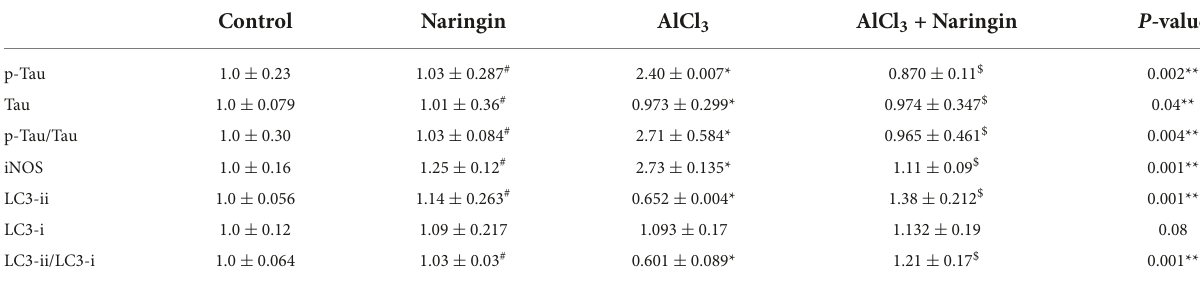
TABLE 3 Effects of naringin administration on the expression of cerebellar LC3, tau and iNOS proteins by Western blot analysis. Control AlCl